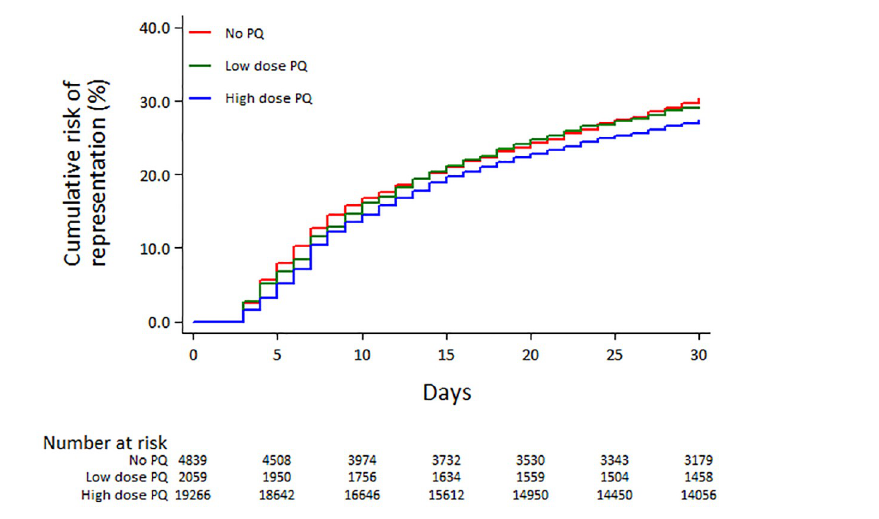
Fig 2. Risk of all cause re-presentation by primaquine (PQ) dose. https://doi.org/10.1371/journal.pntd.0008838.g002 priori subgroup analyses, the rate of death in non-Papuans after high dose PQ was significantly lower than that in patients not treated with PQ; AHR = 0.05 (95%CI: 0.006–0.43); p = 0.006